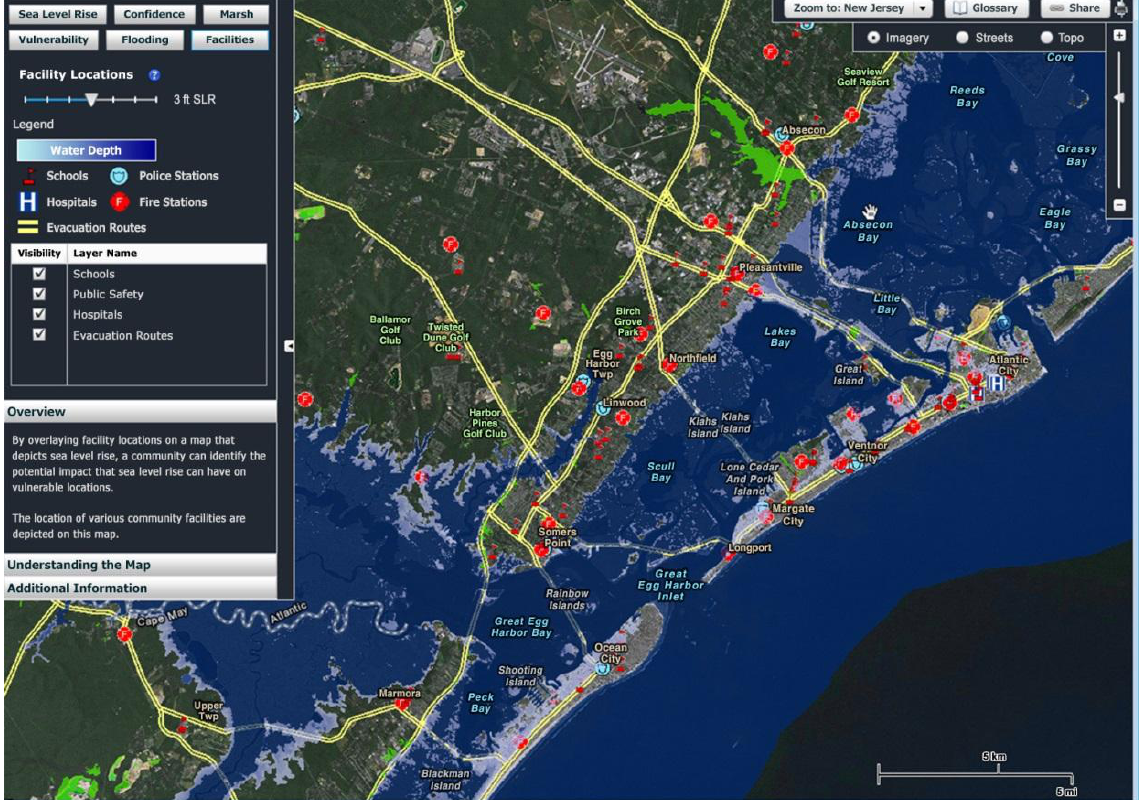
Figure 3. Example of the inclusion of critical facilities and evacuation routes in the NJFloodMapper viewer for the Atlantic City, New Jersey area under three feet of projected sea level